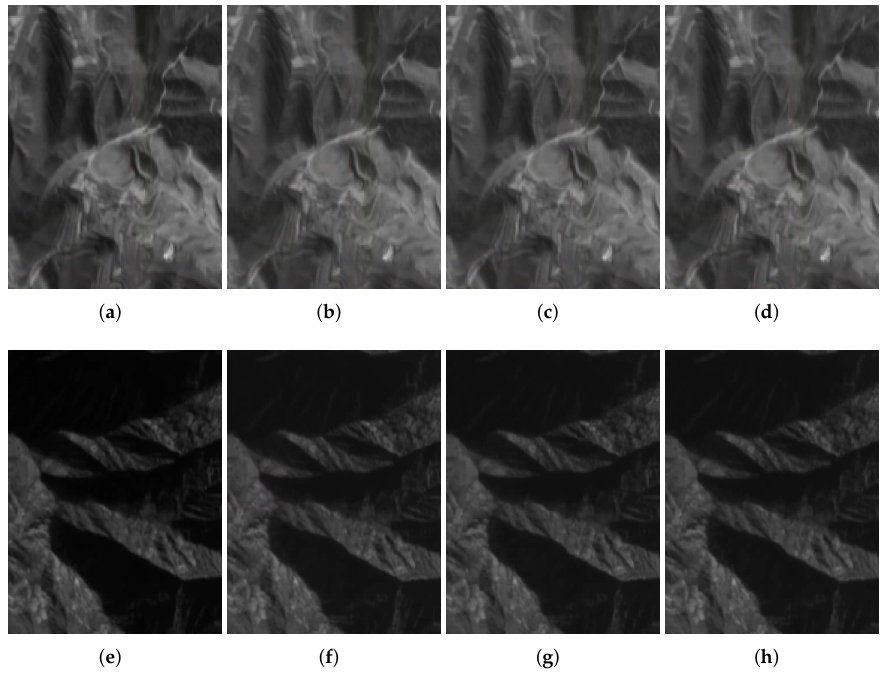
Figure 15. Stitching results for Image Data 4 with different methods: ( a ) traditional line-time nor- malization, ( b ) line-based line-time normalization, ( c ) block-based line-time normalization, ( d ) scene- based line-time normalization, ( e ) traditional line-time normalization, ( f ) line-based line-time normal- ization, ( g ) block-based line-time normalization, ( h ) scene-based line-time